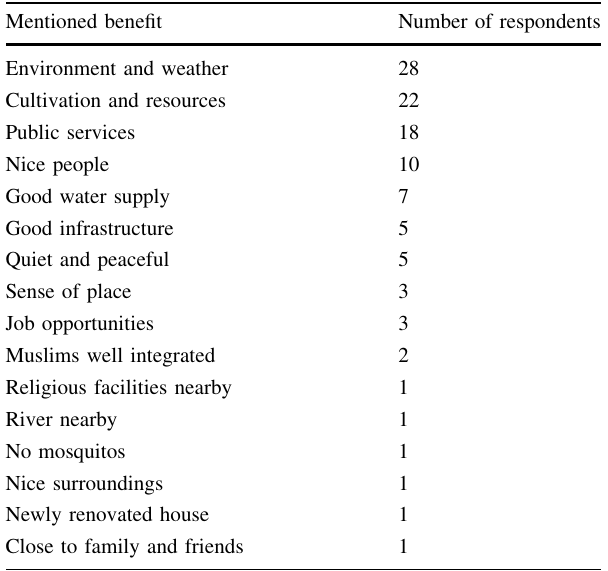
Table 3 Responses from the local residents associated with a sense of place in the Akuressa area of Sri Lanka Sense of